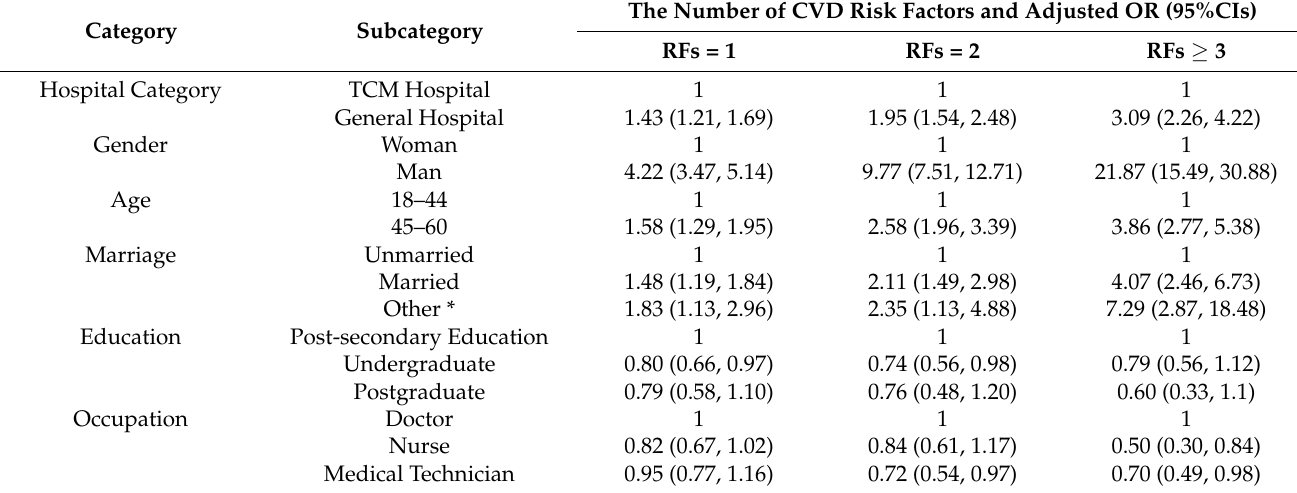
Table 4. The multiple logistic analysis of the CVD risk factor clustering.